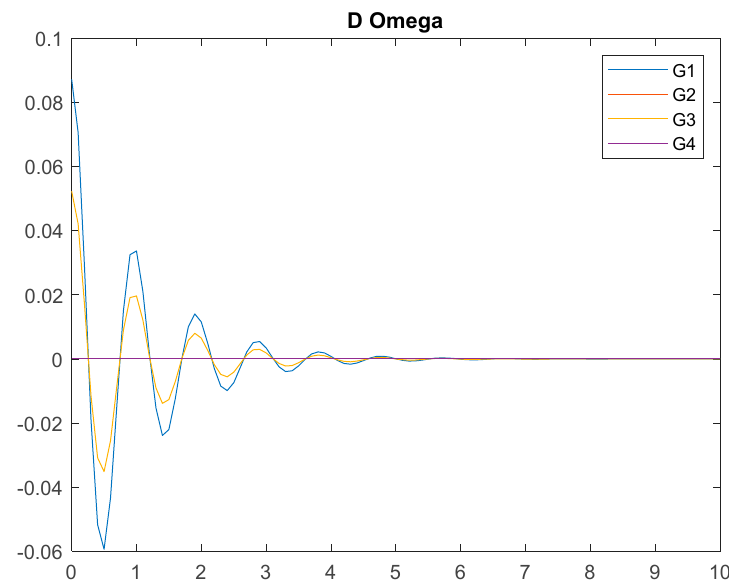
Figure 7. Shows the damping momentum ∆ ω stability diagram of the generators in the power system.